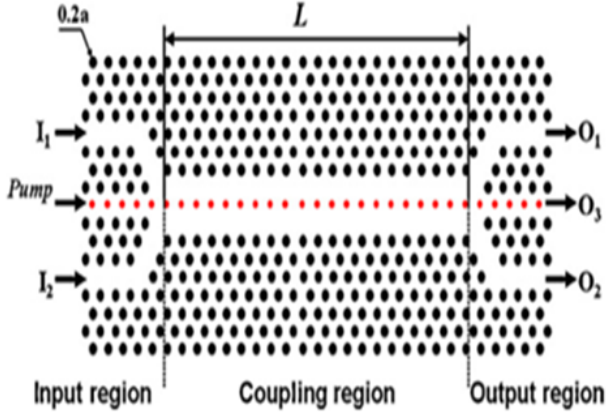
Figure 2 :A directional coupler switch based on Photonic crystal